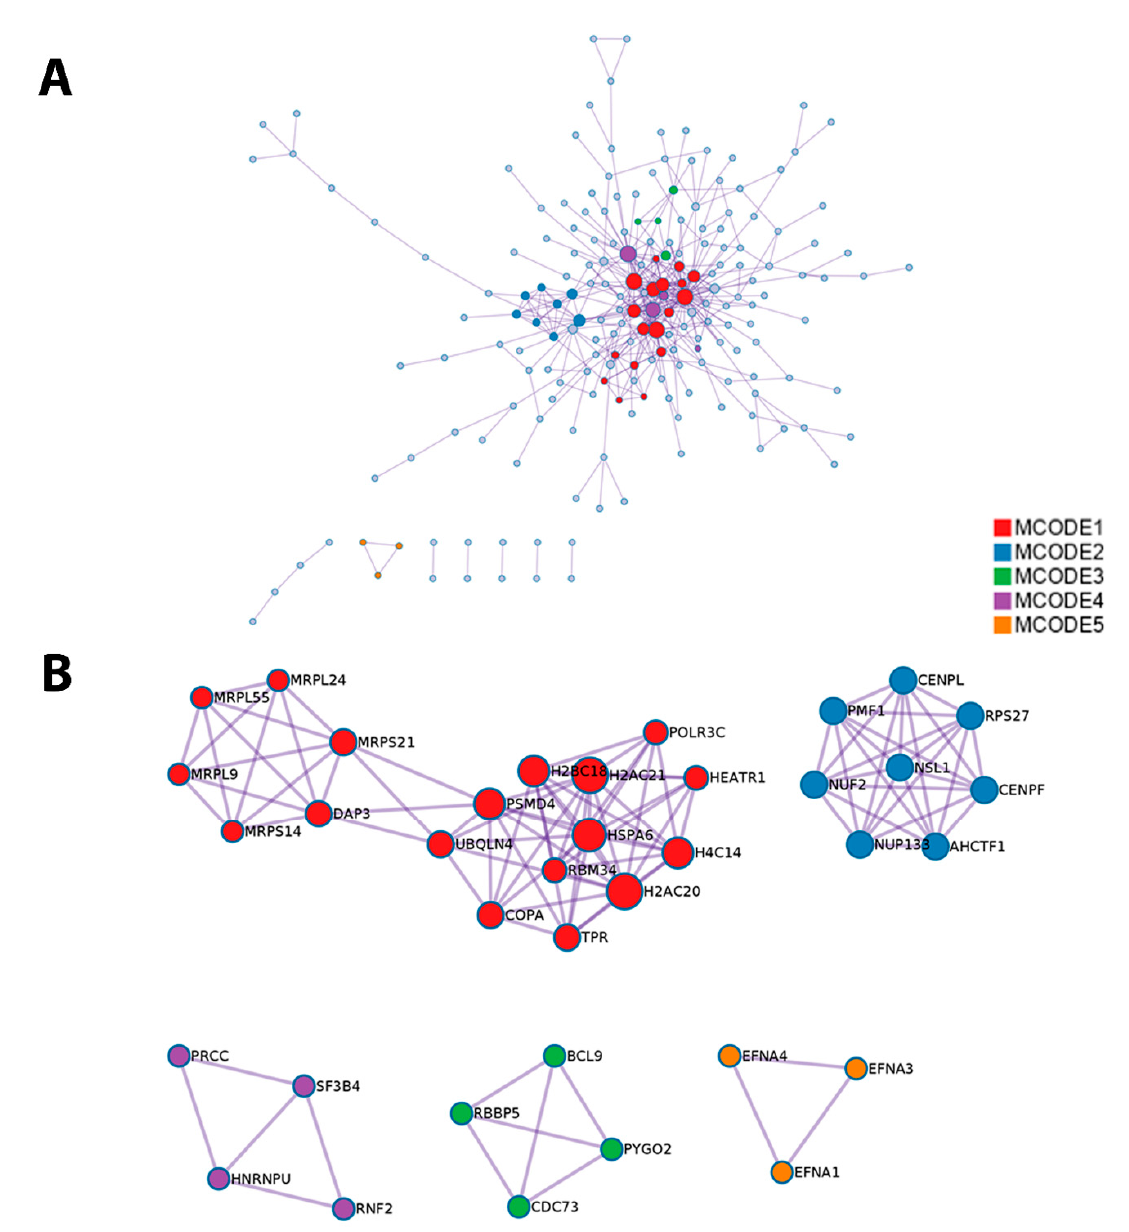
Figure 9. ( A ) Network of protein–protein interaction enrichment analysis in 1q-OverUpT genes in group A; ( B ) results of the application of the Molecular Complex Detection (MCODE) algorithm to this network. Networks were generated by Metascape.